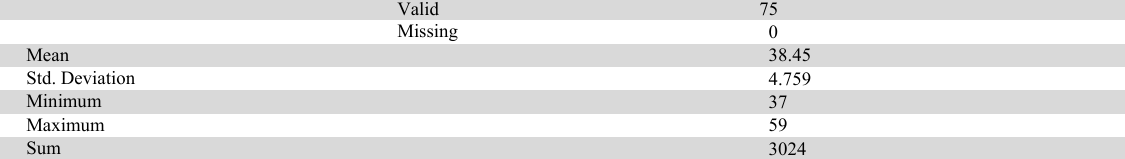
Valid 75 Missing